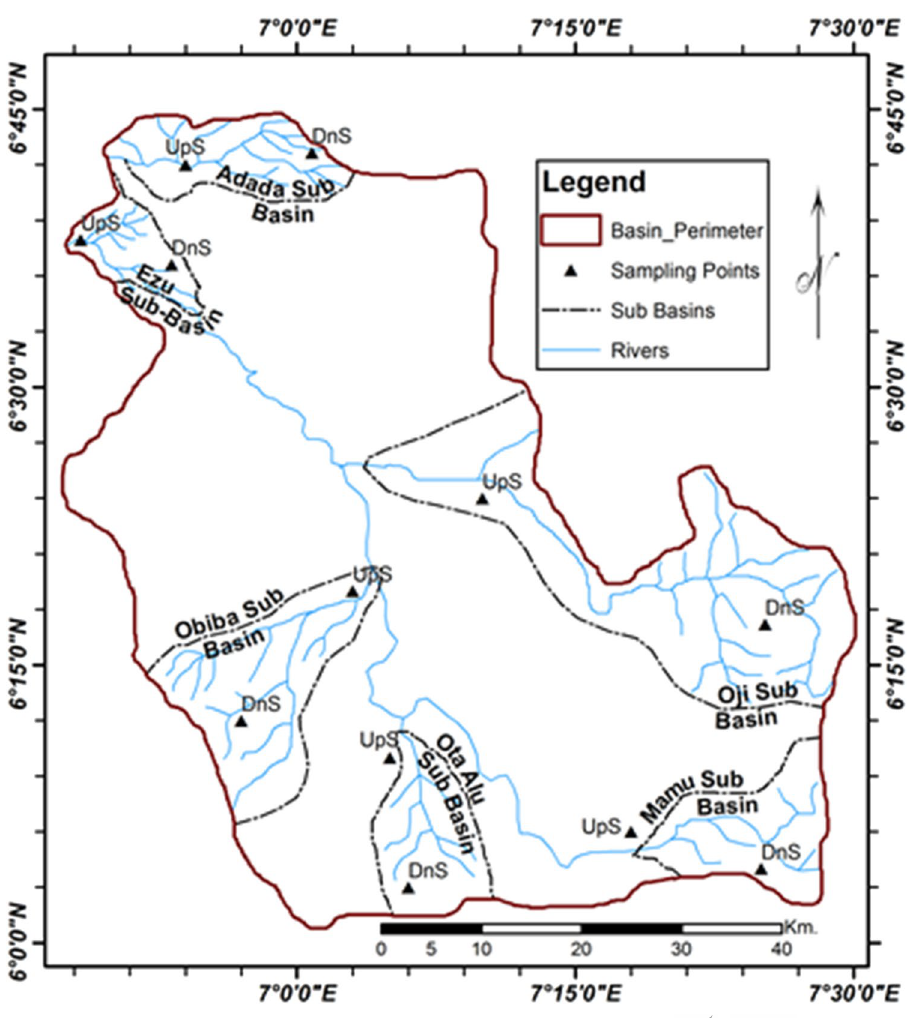
Fig. 2 Mamu River basin map